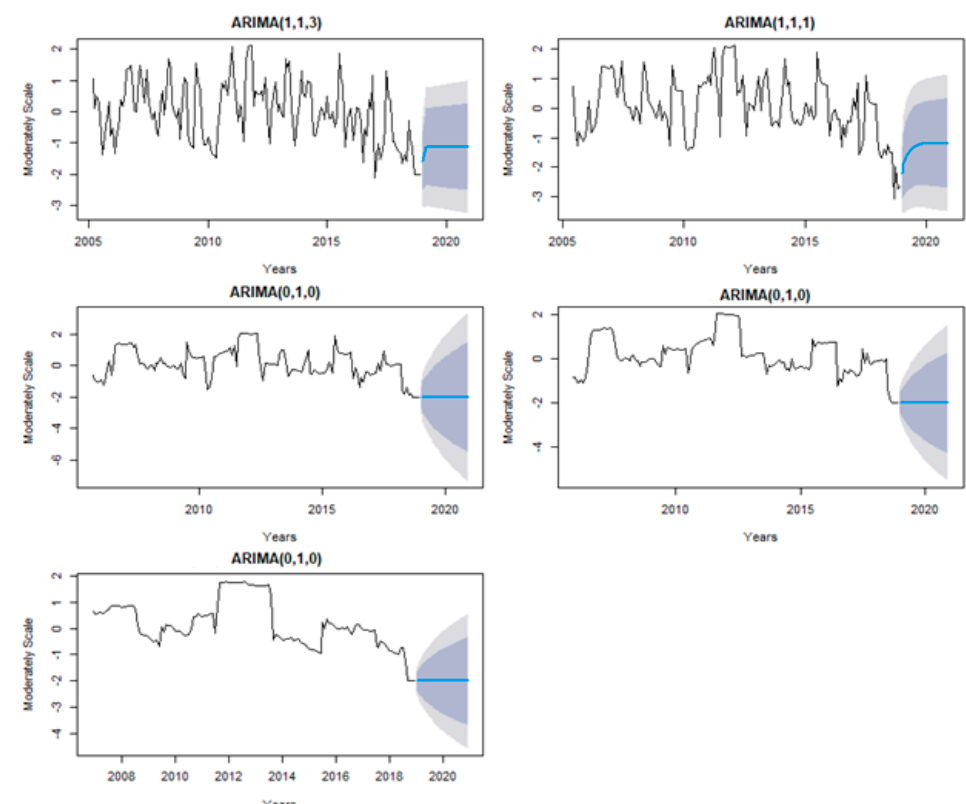
Figure 9. The long-term projection of SPEI for 5 year.